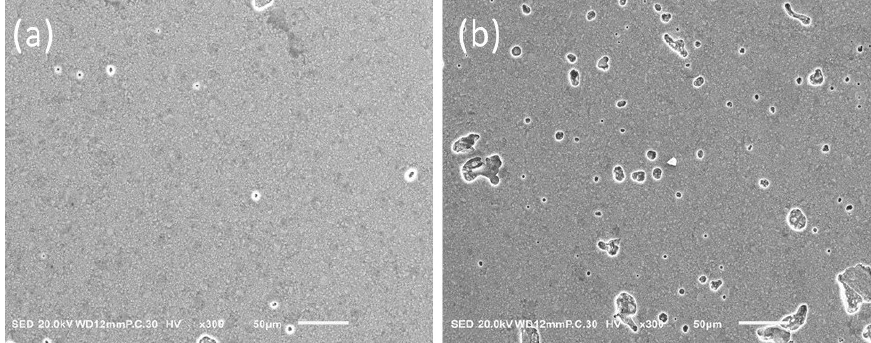
Figure 2. Difference in APX surface before ( a ) and after ( b ) immersion in solution for one week.